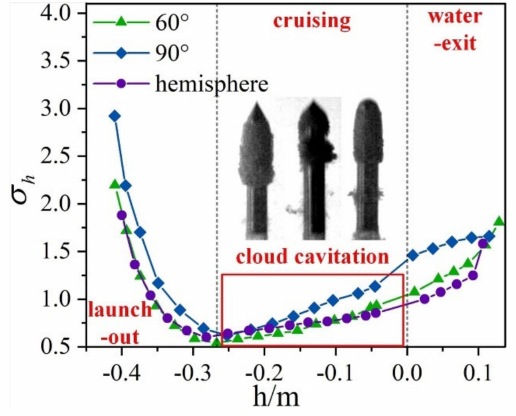
Figure 7. Variation curve of the local cavitation number with